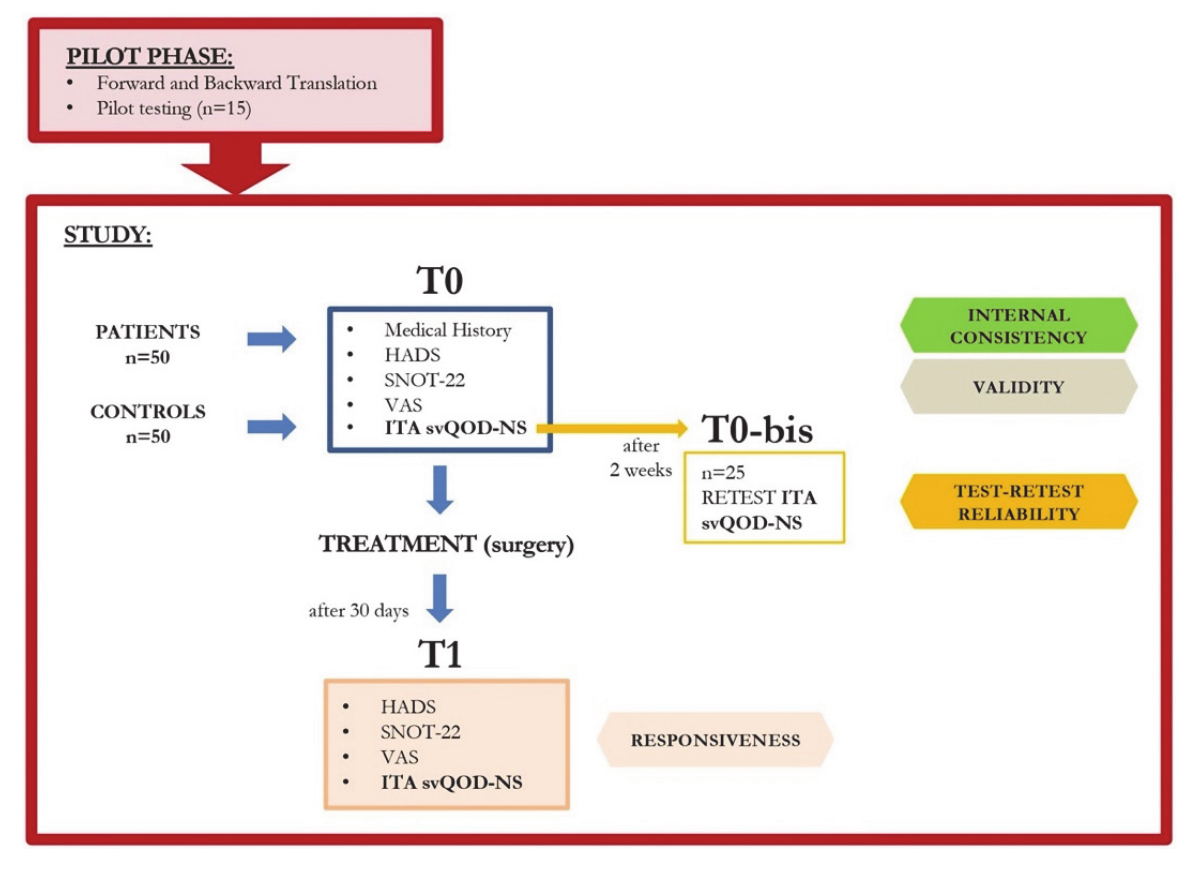
Figure 1. Design of the study .